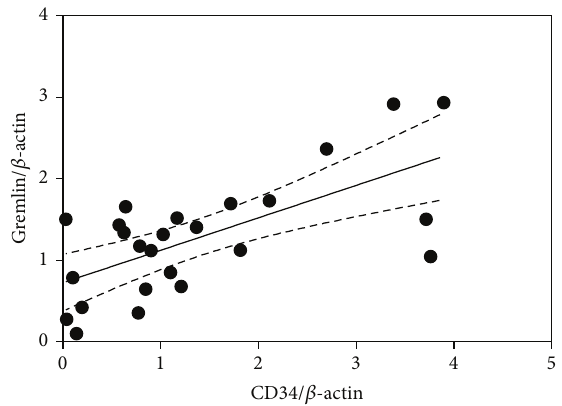
Figure 4: Linear regression analysis of tissue microarray data. Normalized Gremlin and CD34 levels were significantly correlated ( 𝑃 < 0.005 ; 95% confidence interval: 0.025–0.042; 𝑟 2 = 0.4958 ; 𝐹 = 32.24